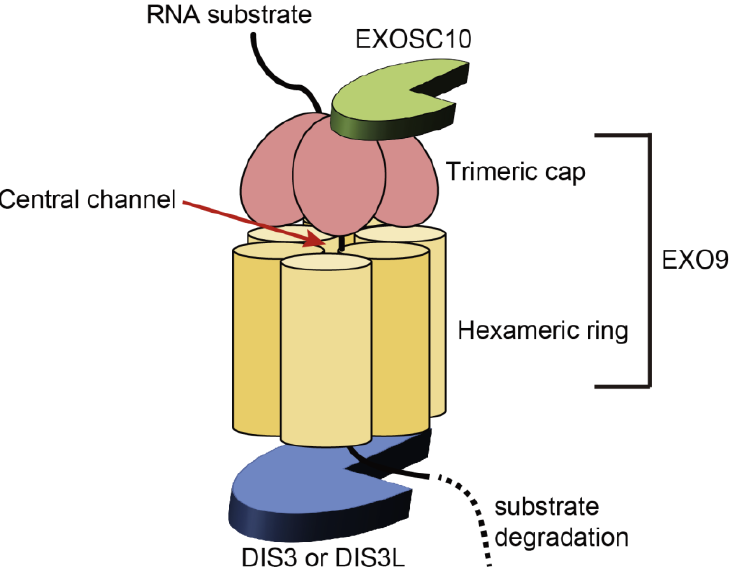
Figure 1. Structure of the RNA exosome. The RNA exosome comprises an enzymatically inactive, barrel-shaped nine-subunit core (EXO9) and two catalytic subunits (DIS3/DIS3L and EXOSC10). EXO9 includes a hexameric ring (EXOSC4, EXOSC5, EXOSC6, EXOSC7, EXOSC8, and EXOSC9) and a trimeric cap (EXOSC1, EXOSC2, and EXOSC3). The catalytic subunit, DIS3, or its homologue, DIS3L, interacts with EXO9 at the bottom of the hexameric ring in a mutually exclusive manner. The other catalytic subunit, EXOSC10, binds to the cap side of EXO9. RNA substrates are threaded through a central channel to the catalytic core of DIS3 or DIS3L for degradation. Table 1. Functions of the RNA